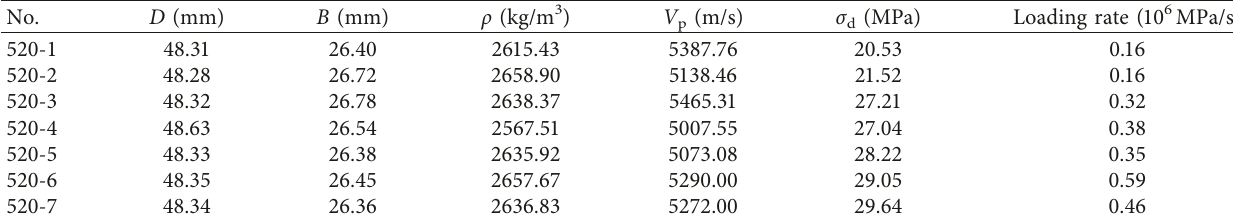
Table 7: Testing result of the dynamic tension test at depth 520m.